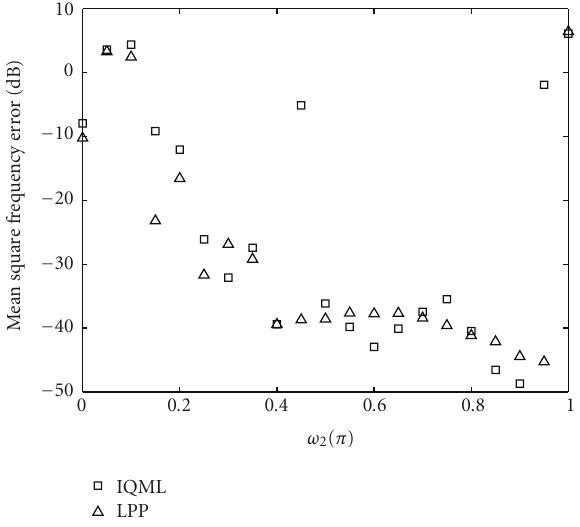
Figure 25: MSE for μ of 2D single complex